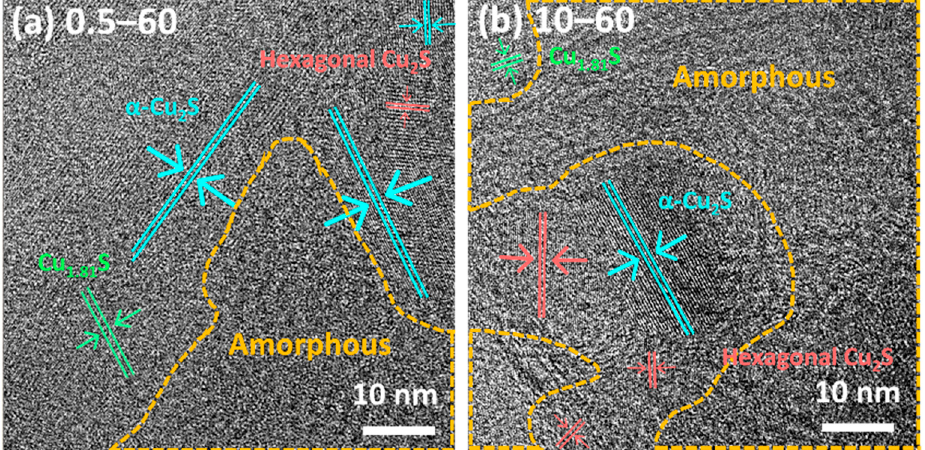
Figure 4. HRTEM images of the samples with c = 0.5 and 10 mM of Na 2 S solution for the reaction time of t = 60 min: ( a ) 0.5–60 sample and ( b ) 10–60 sample. The yellow dashed regions indicate the amorphous structures, and the red, cyan, and green lines denote the hexagonal Cu 2 S, α -Cu 2 S, and Cu 1.81 S phases,